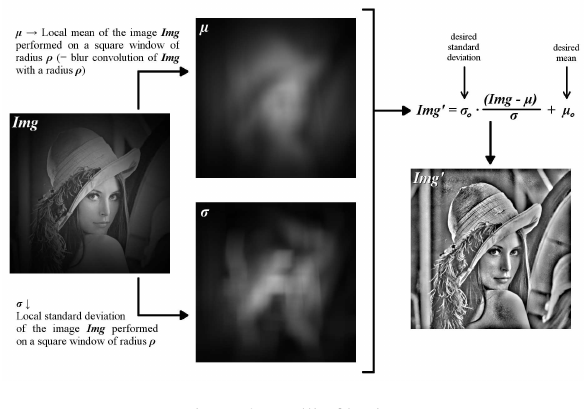
Figure 3: Wallis filtering